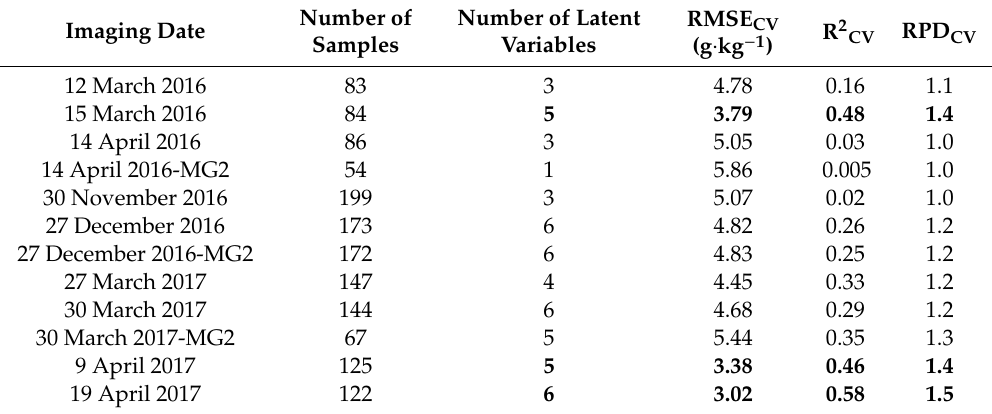
Table 4. Sentinel-2 (S2) prediction performance by date (in bold characters, intermediate performance)—NDVI ≥ 0.35. MG2 denotes the models based on samples not influenced by clouds or shadows according to the MG2